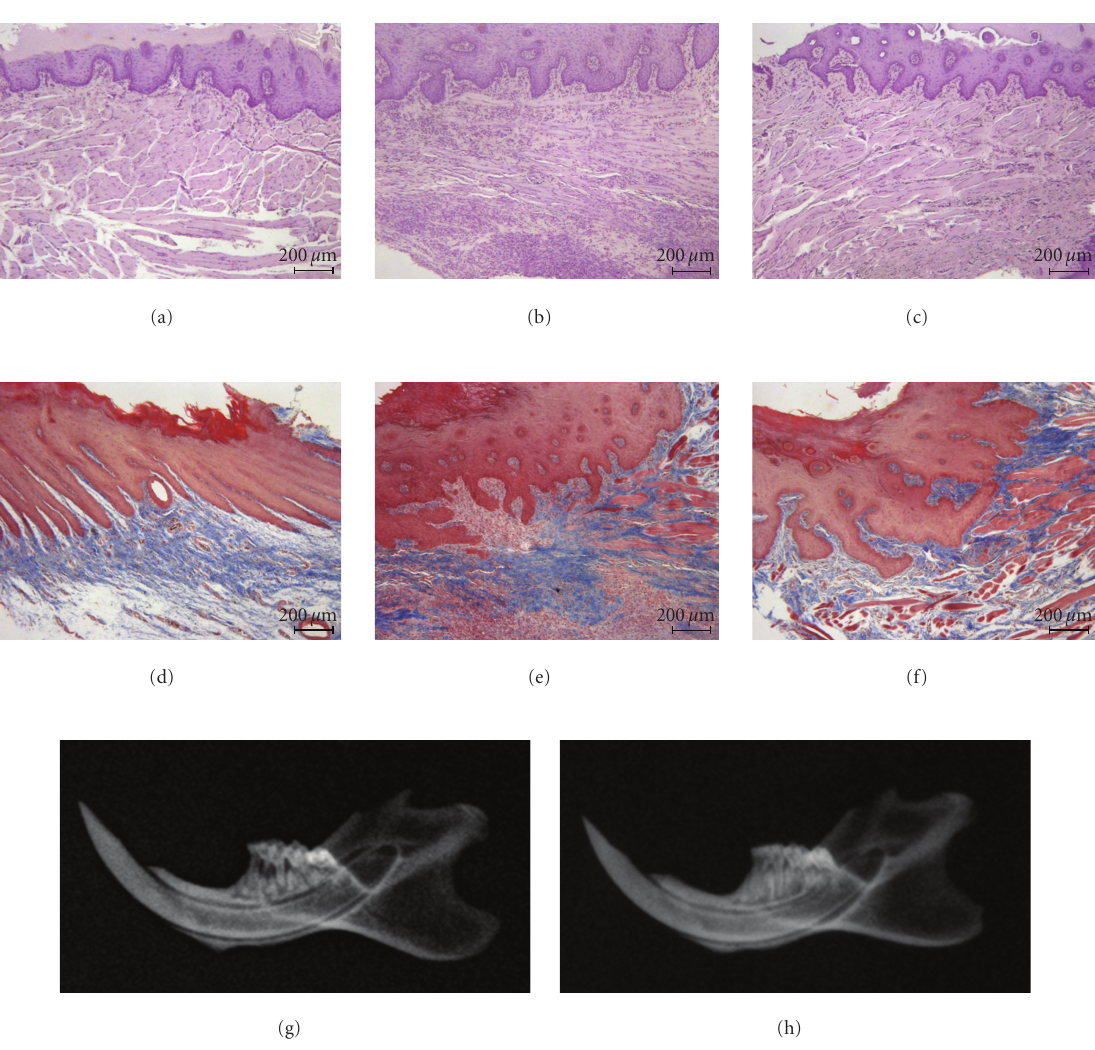
Figure 1: E ff ect of WY14643 on tissue damage and bone resorption. Gingivomucosal section from contra lateral side obtained from vehicle- treated rats (a) demonstrating no tissue damage. Inflammatory cells infiltration and edema was observed in gingivomucosal section from ligature-treated rats. (b) Significantly less edema and inflammatory cells infiltration was observed in gingivomucosal section from ligature- treated rats which have been treated with WY14643. (c) Moreover Masson’s trichrome stain was negative in gingivomucosal tissue sections taken from the contra lateral side (d) from vehicle when compared with gingivomucosal tissues sections of ligature-operated rats. (e) WY14643 treatment reduced the increase of collagen. (f) The alveolar bone from ligated rats demonstrated alveolar bone resorption. (g) WY14643 treatment suppressed alveolar pathology in the rat alveolar bone. (h) Figure is representative of at least 3 experiments performed on di ff erent experimental